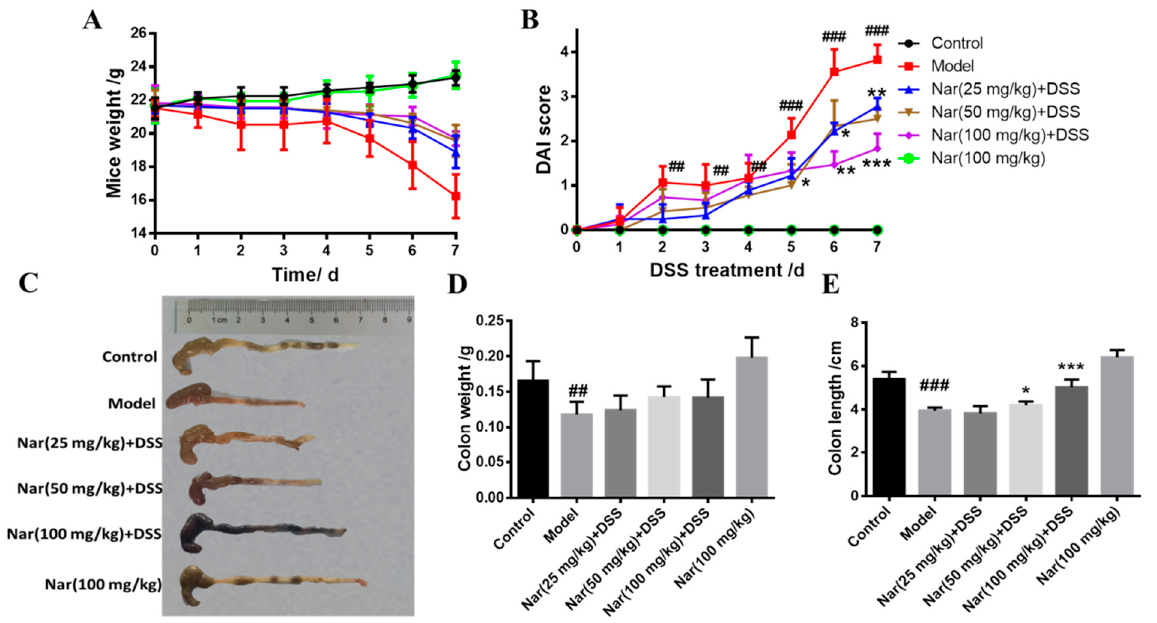
Figure 1. Naringin could alleviate the symptoms of DSS-induced colitis in mice. ( A ) Changes in body weight of mice during the experiment. ( B ) DAI score. ( C ) Appearances of the colon tissues. ( D ) Weights of colon in different groups. ( E ) Lengths of colon in different groups. Data are presented as means ± SD ( n = 10 per group). ## p < 0.01 and ### p < 0.001, compared with the control group; * p < 0.05, ** p < 0.01 and *** p < 0.001, compared with the model